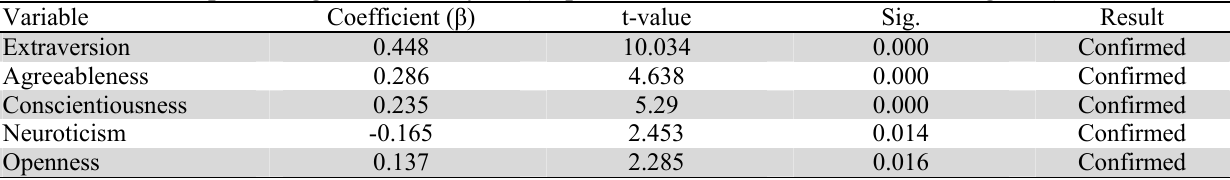
The results of stepwise regression analysis (Dependent variable: Emotional intelligence) Variable Coefficient ( β ) t-value Sig.